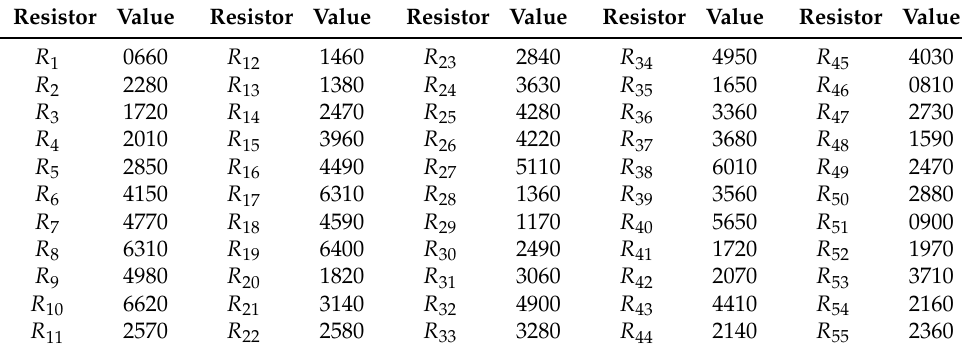
Table 5. Resistor values for the Puebla